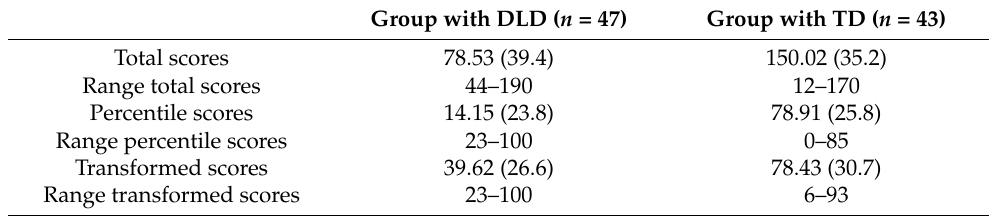
Table 3. Scores in morphology